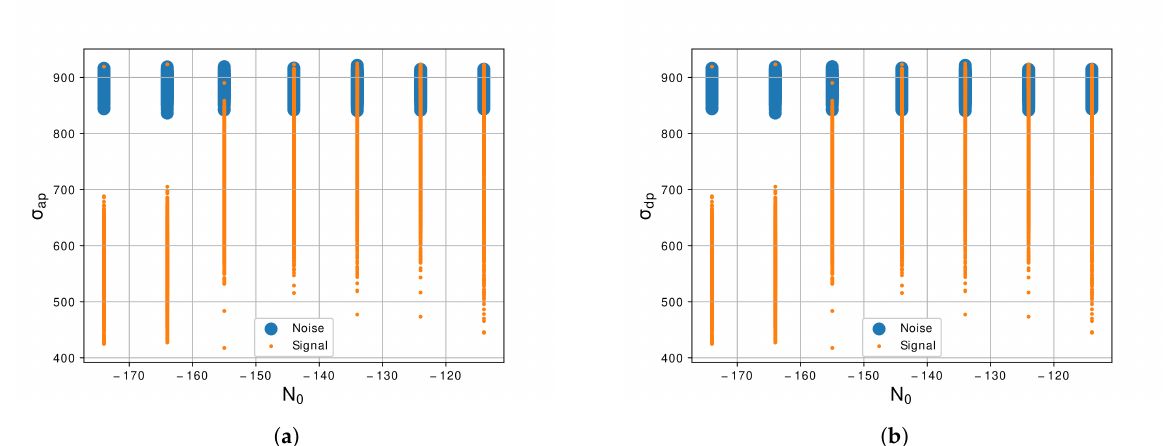
Figure 5. Graphic of the features ( a ) σ ap , Equation (5), and ( b ) σ dp , Equation (6), with the variation of N 0 of − 114 dBm/Hz to − 174 dBm/Hz.